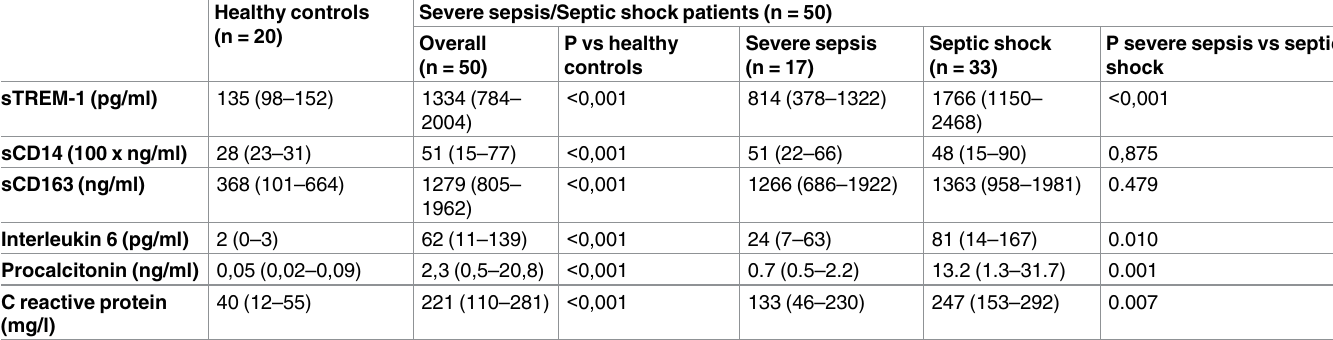
Table 2. Serum concentrations of biomarkers in patients with severesepsis/septic shock and healthy controls. Healthy controls (n = 20)